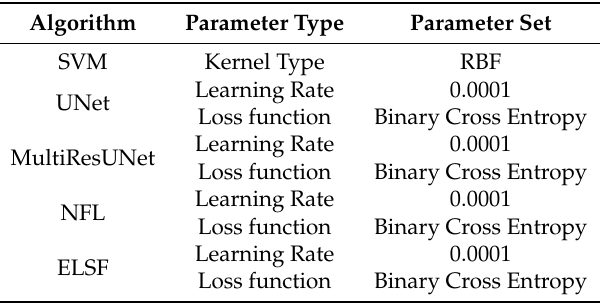
Table 2. Parameters for the algorithm training